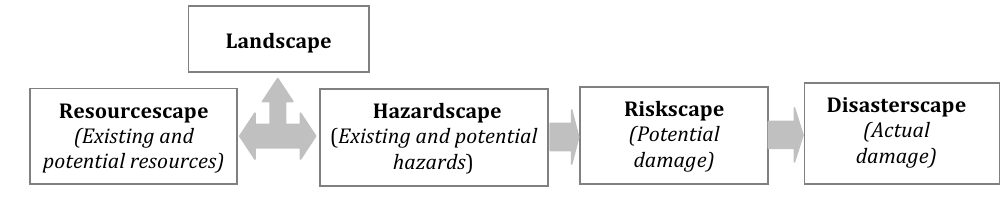
Fig 1 Relationship between hazardscape, riskscape and disasterscape Fig. 1. Relationship between hazardscape, riskscape and disasterscape.